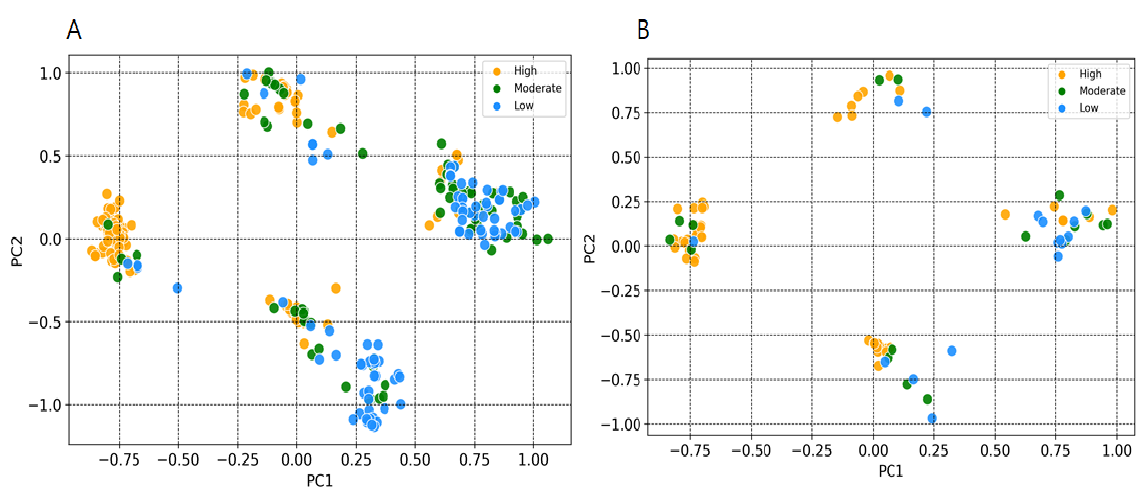
Figure 6. Applicability domain plot based on principal component analysis (PCA) using eighteen selected descriptors set. ( A ) Training set. ( B ) Test set.